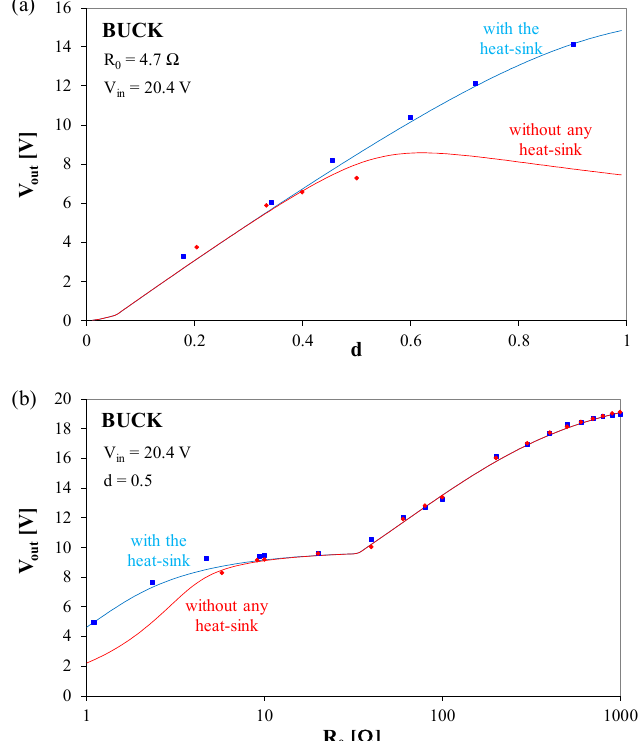
Figure 6. Dependences of the buck converter output voltage on: ( a ) the duty cycle d, ( b ) on load resistance.